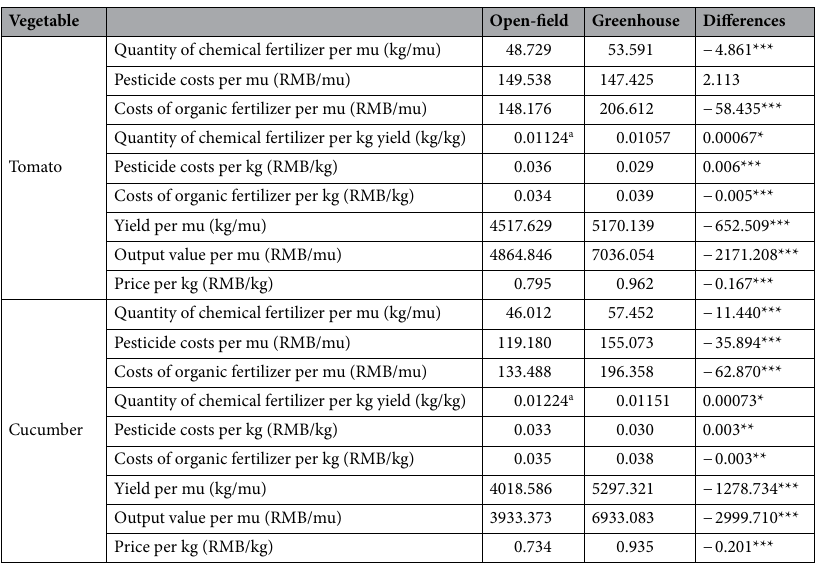
Table 1. Application levels of fertilizer and pesticide. *,**,*** indicate statistically significance at the 10%, 5% and 1%, respectively. 1 hectare = 15 mu. Quantity of chemical fertilizer used here is the net quantity calculated after purification. a We keep 5 decimal places due to the small